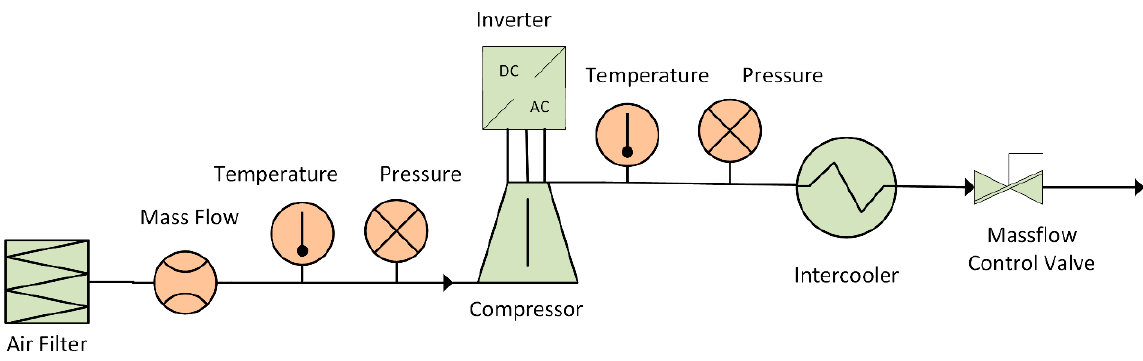
Figure 1. Schematic of the test bench setup, including air filter, compressor with inverter, intercooler, mass flow control valve and sensors.